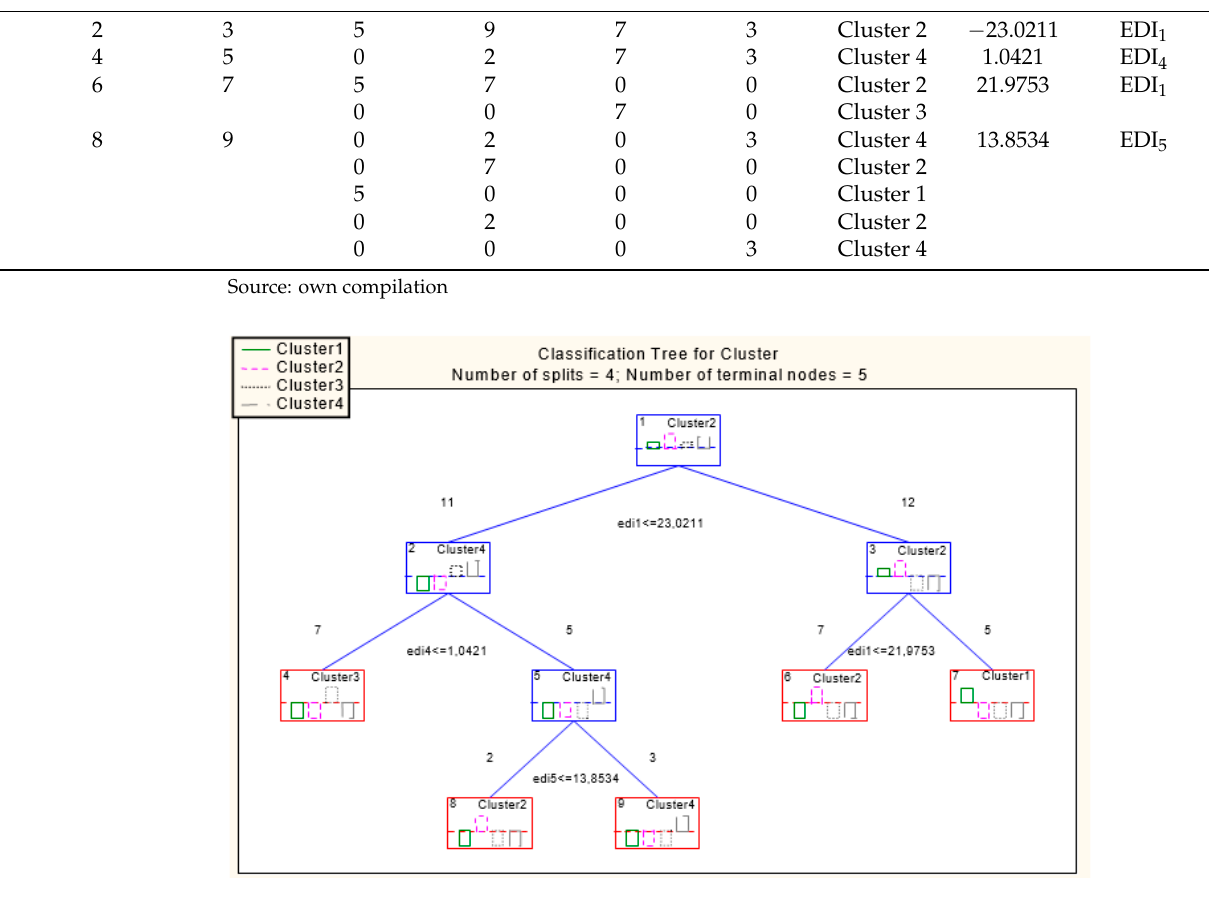
Figure 7. Classification tree of countries by modeling scenarios of sustainable energy development. Source: own data.